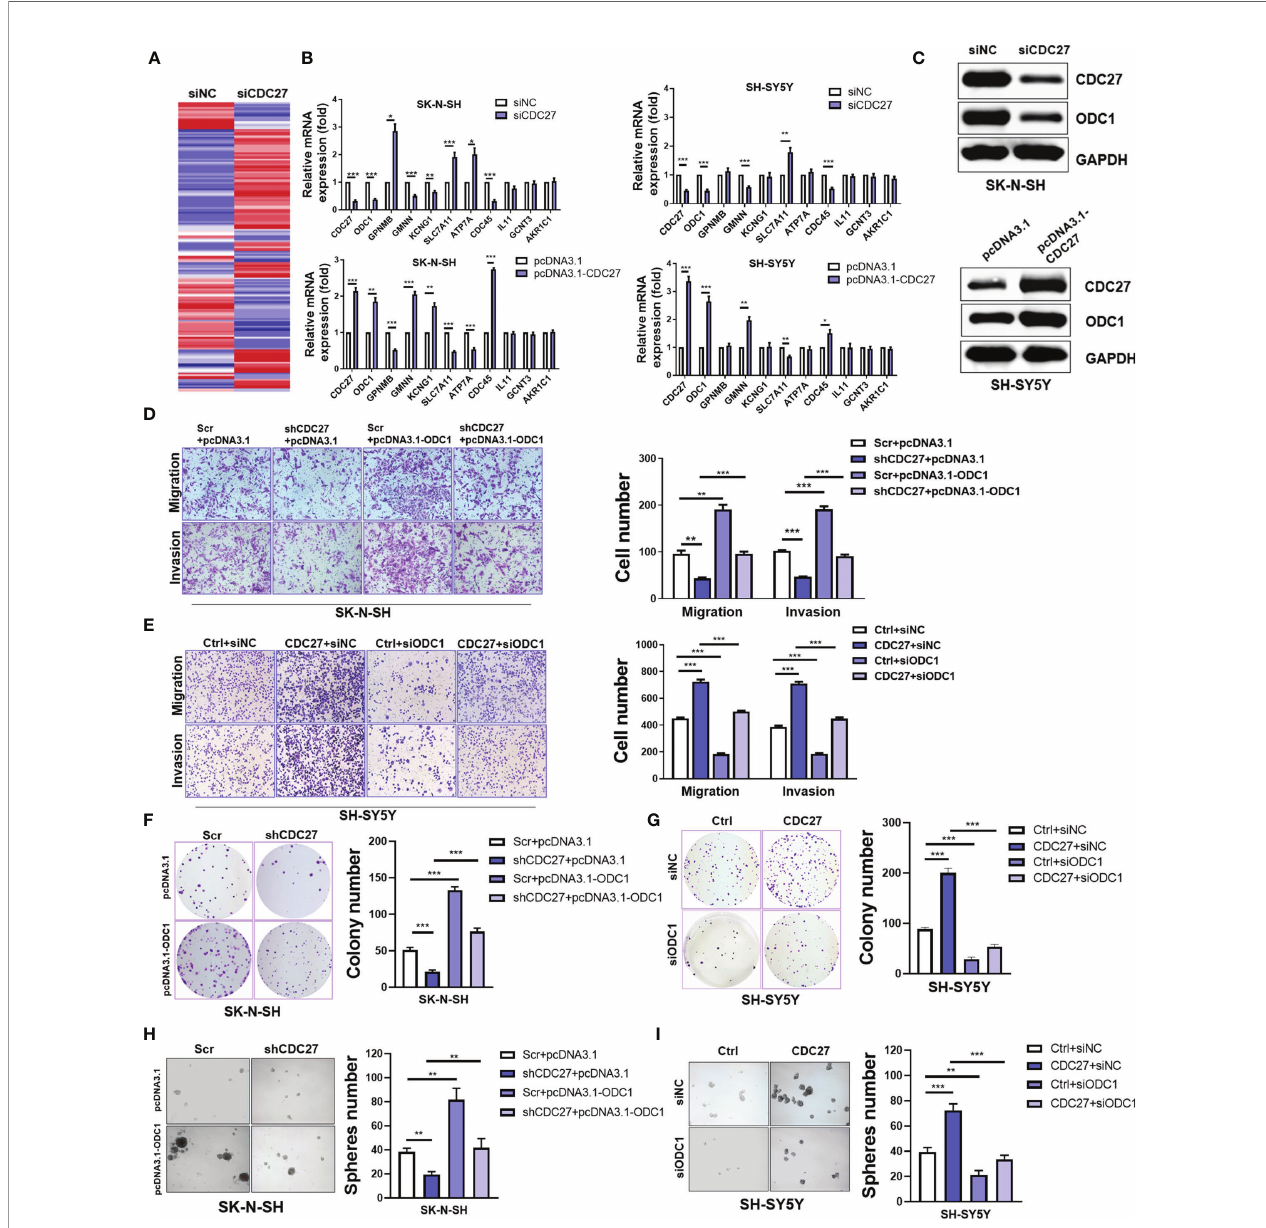
FIGURE 3 | CDC27 promoted proliferation and metastasis by ODC1 activation. (A) Heatmap for differentially expressed genes from RNA-sequencing results. (B) Relative mRNA expression level of selected genes normalized to b -actin level in SK-N-SH and SH-SY5Y cells with CDC27 transiently knocked down or overexpressed by real time RT – PCR. (C) Validation of ODC1 expression by western blot. (D – I) ODC1 was transiently overexpressed or suppressed in the indicated stable cell lines. Representative images of colony formation, Transwell, and sphere-formation rescue assays are shown, and quanti fi cations are presented. The means ± SD of triplicate samples are shown. ***p < 0.001, **p < 0.01, *p < 0.05 based on Student ’ s t